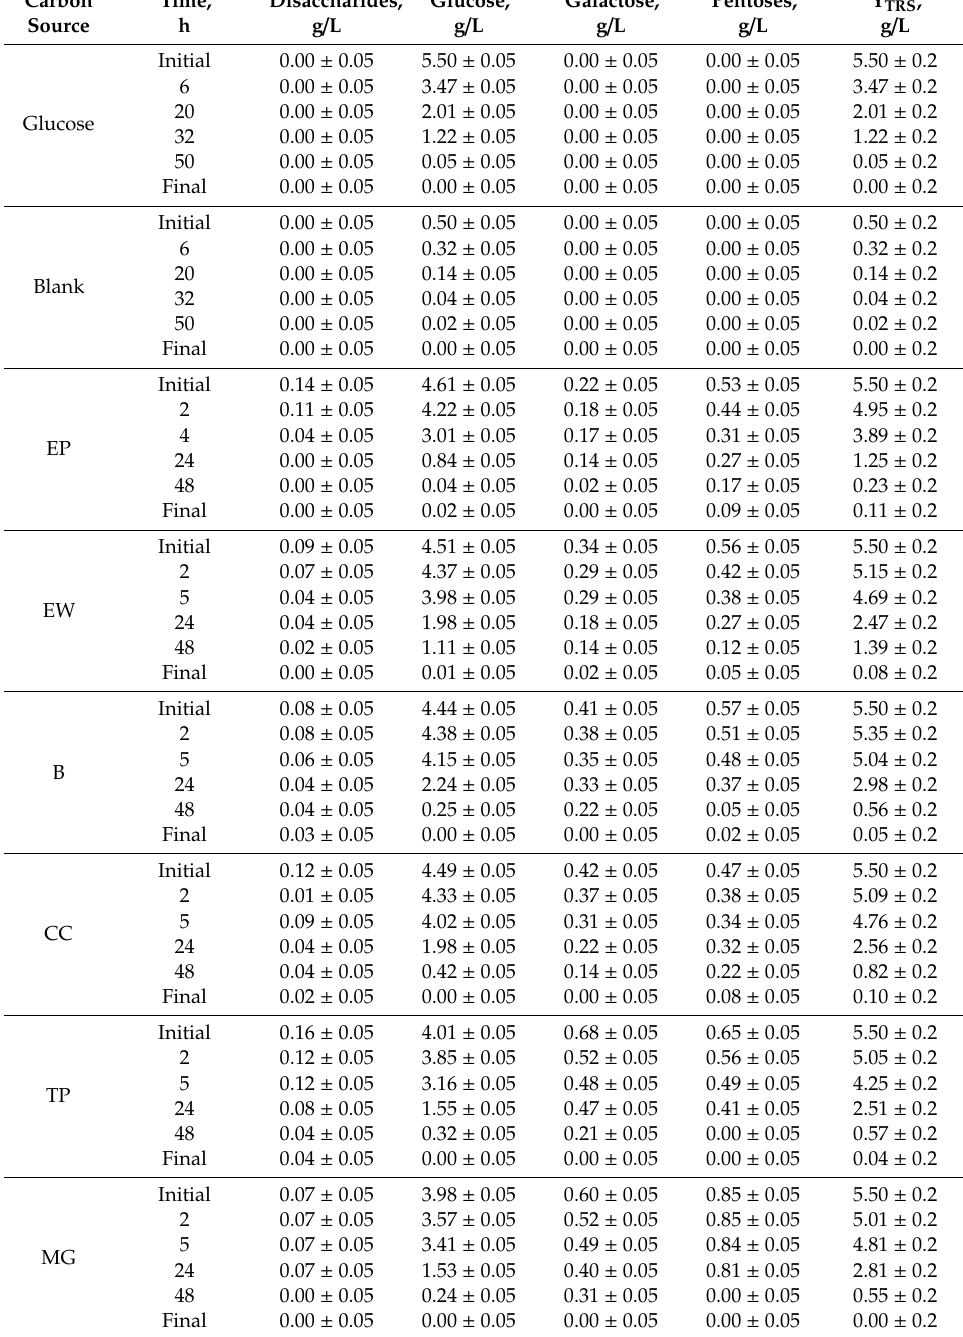
Table 5. Changes in the sugar concentration during dark fermentation for di ff erent